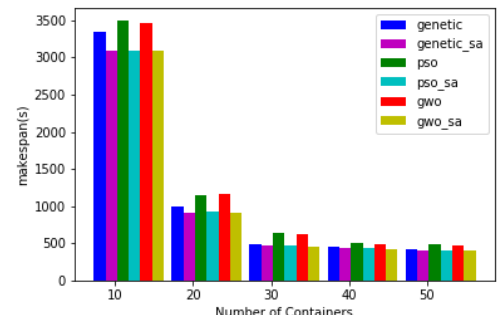
Figure 10. Load variation with 2000 tasks.